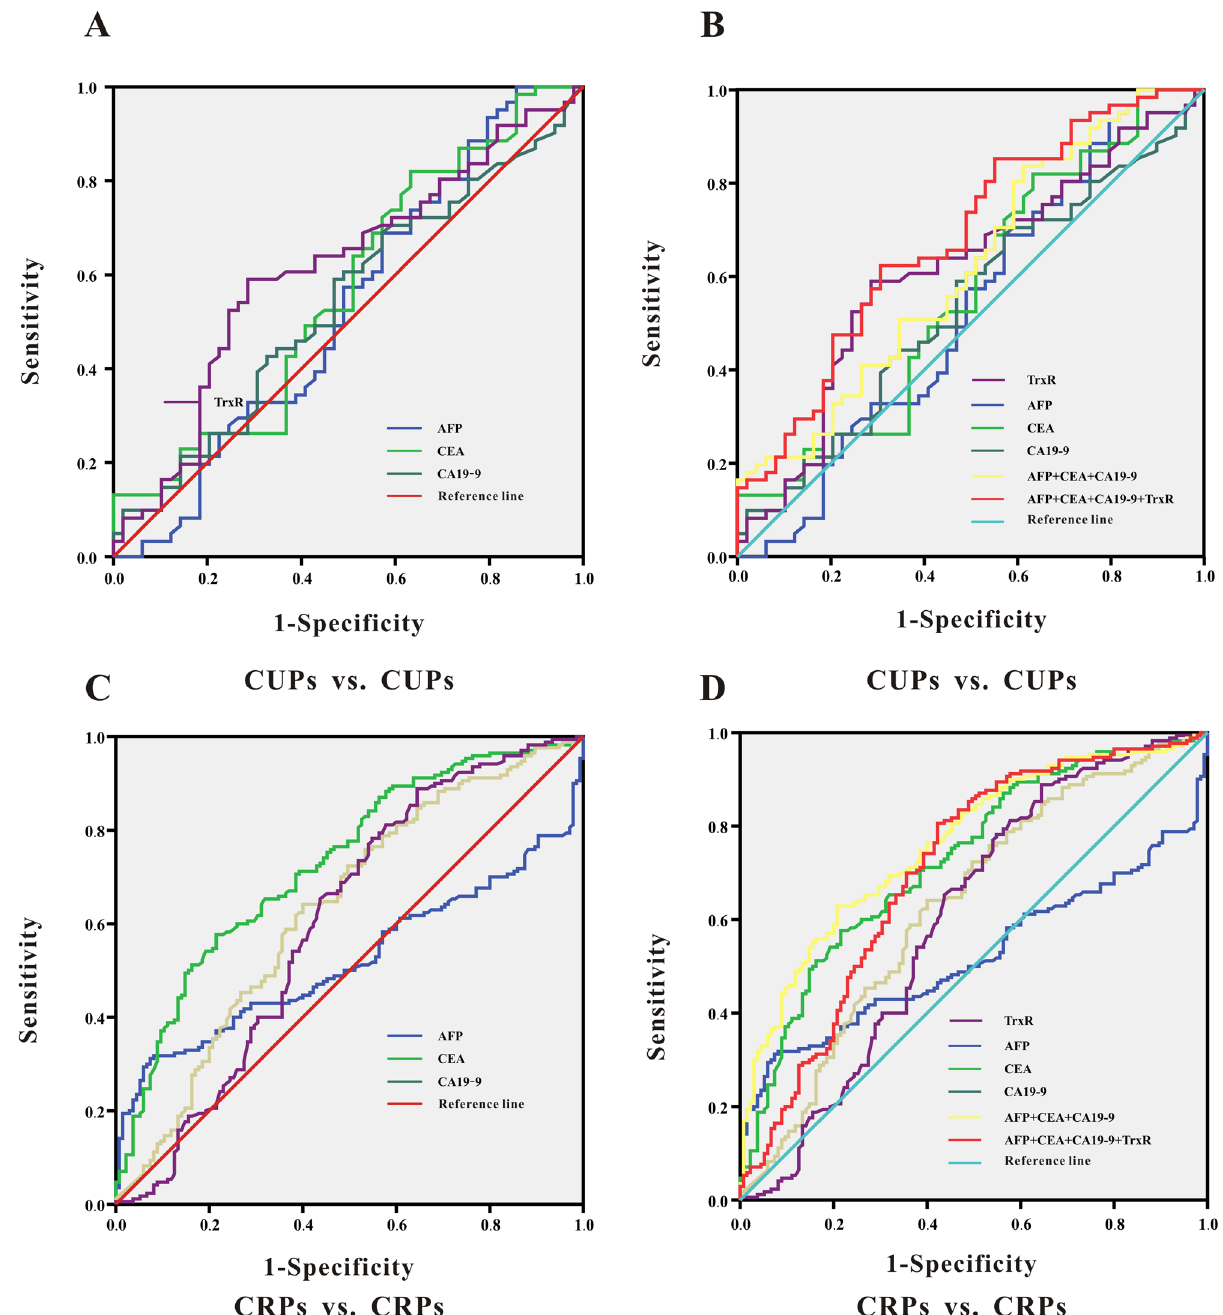
Figure 5. ( A , B ) ROC curve analyses of TrxR, AFP, CEA, CA19-9 ( A ), and the combinations ( B ) for the differentiation of CUPs with different cancer types (PLCs vs. MLCs). ( C , D ) ROC curve analyses of TrxR, AFP, CEA, CA19-9 ( C ), and the combinations ( D ) for the differentiation of CRPs with different cancer types (PLCs vs.